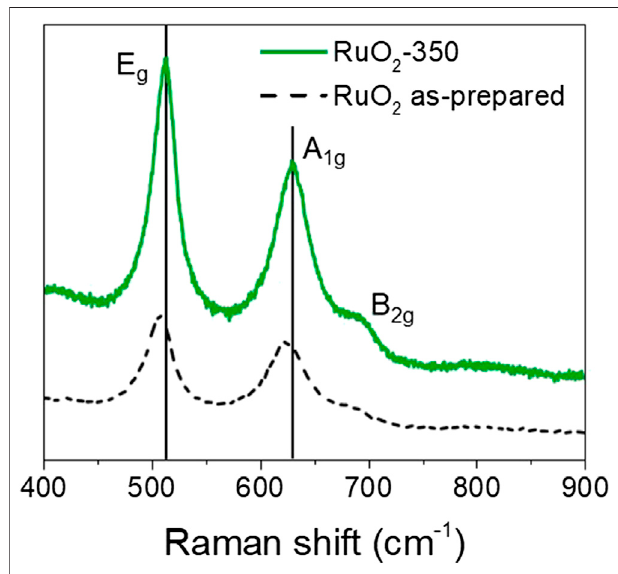
FIGURE 4 | Raman spectra of H-RuO 2 (dashed line) and C-RuO 2 (solid line).